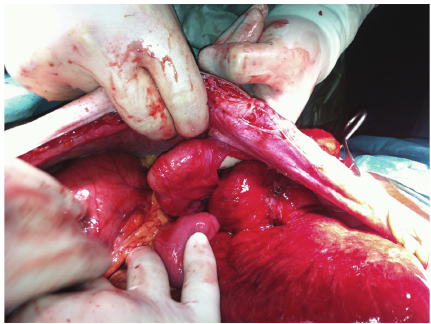
Figure 3: Perforation site of the